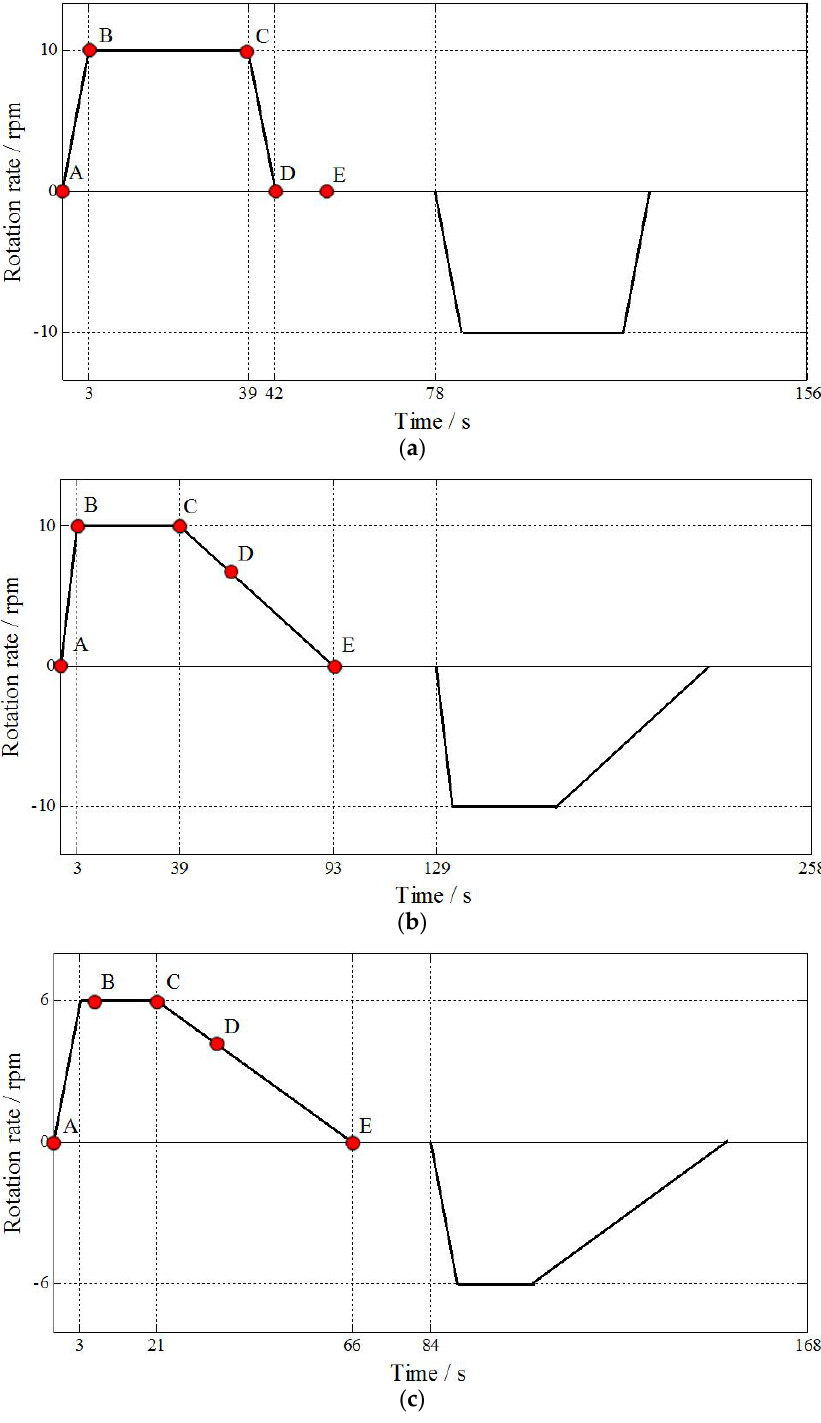
Figure 3. ACRT sequences. ( a ) Sequence 1, E is 6 s after D; ( b ) Sequence 2, D is 18 s after C; ( c ) Sequence 3, B is 3 s after the beginning of the constant rotation stage, D is 15 s after